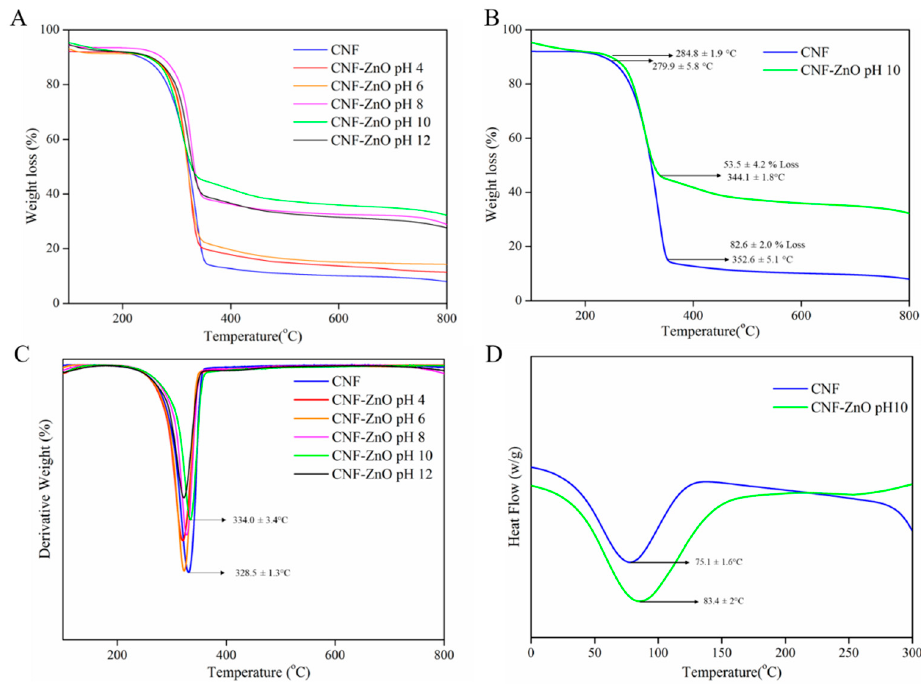
Figure 4. ( A ) TGA analysis for the all samples, ( B ) Detailed TGA analysis for pure CNF and CNF- ZnO pH 10, ( C ) DTG curve for pure CNF and CNF-ZnO pH 10, and ( D ) DSC analysis for pure CNF and CNF-ZnO pH 10.